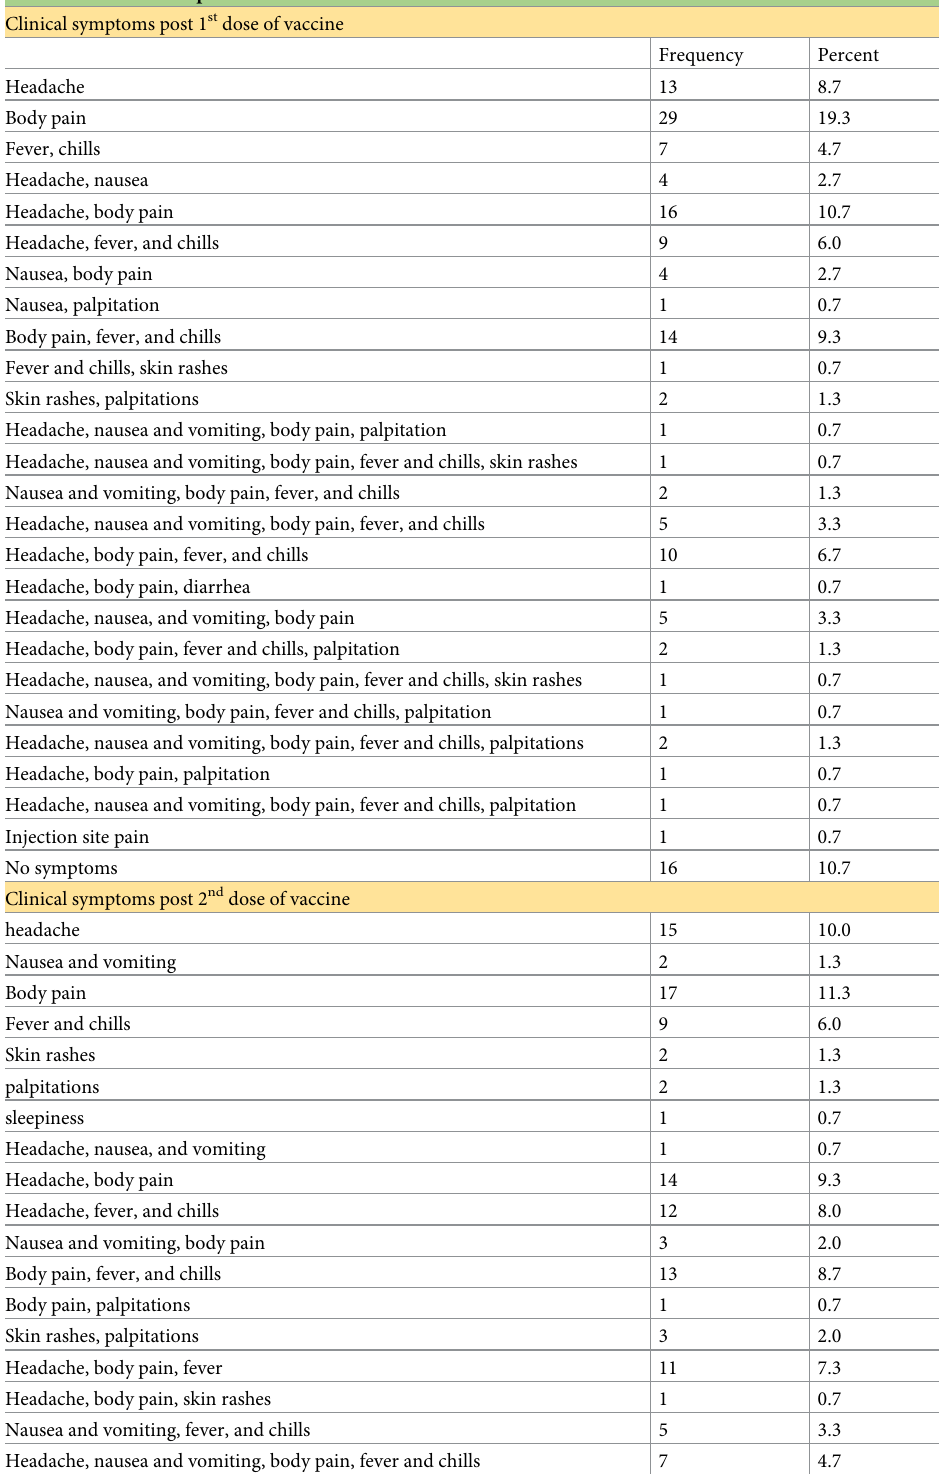
Table 5. Clinical manifestation post